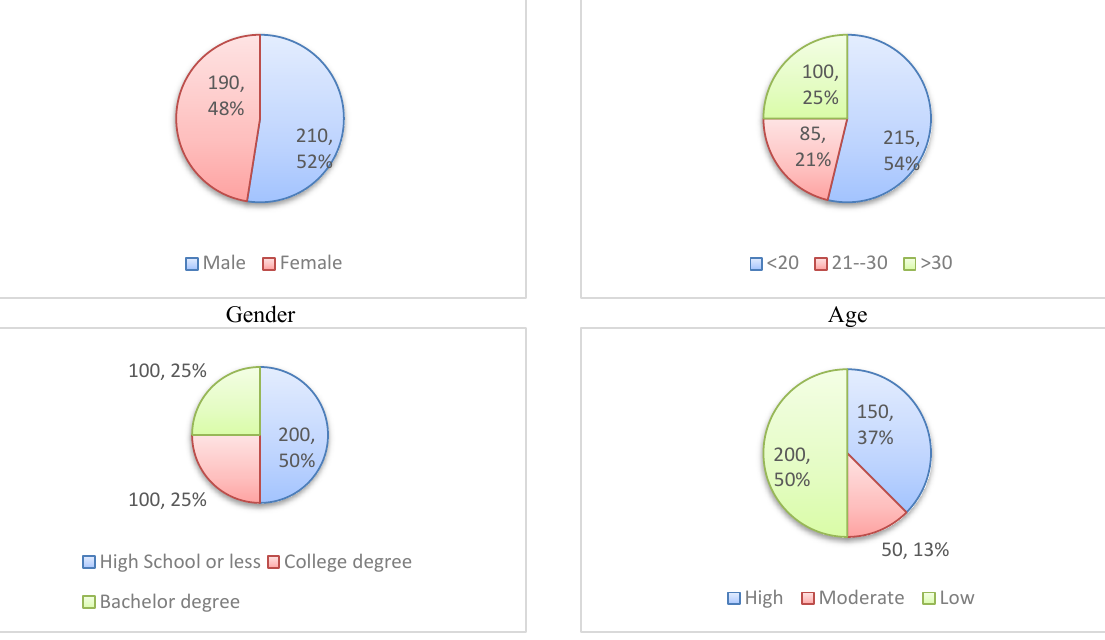
Fig. 2. Characteristics of the respondents. (N = 400)